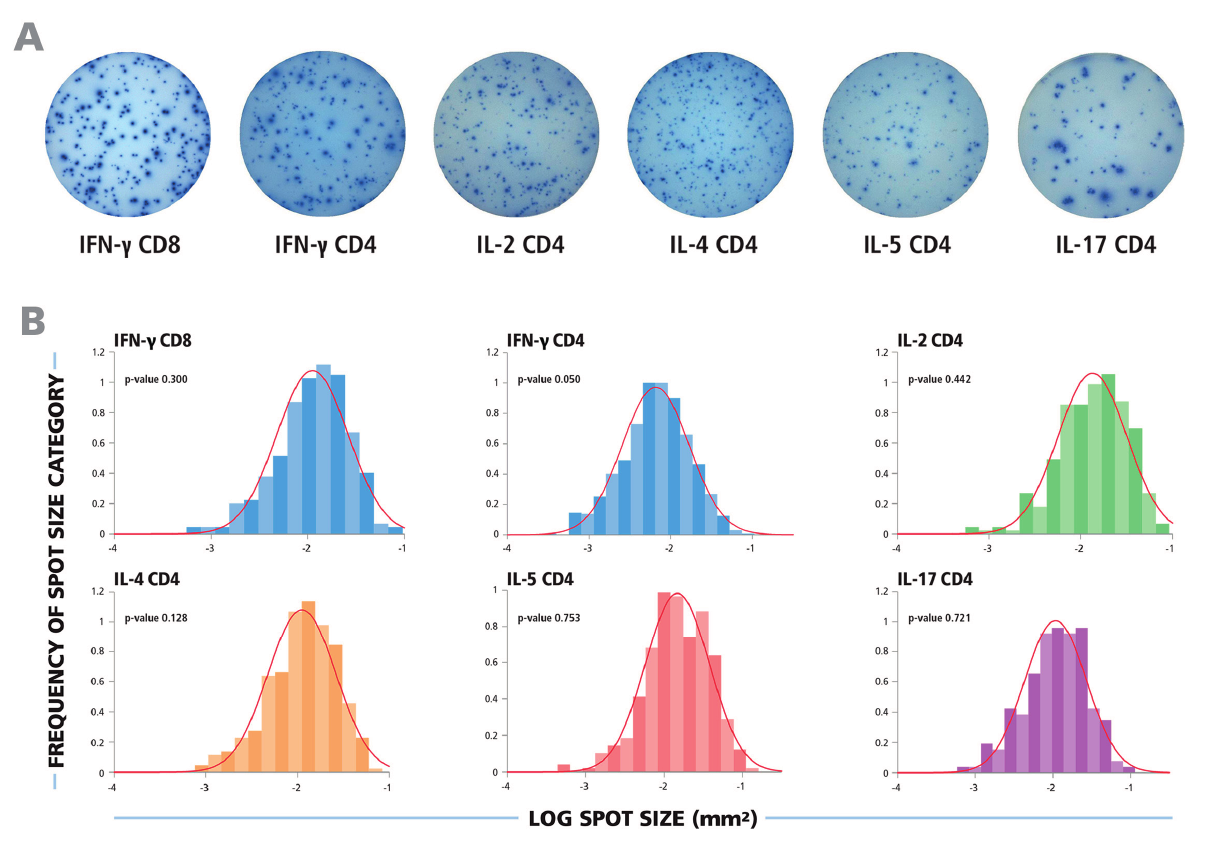
Figure 1. The spot size distributions for different cytokines follow Log Normal function. ( A ) Representative images of ELISPOT wells are shown for cytokines produced by CD8 or CD4 cells, as specified. ( B ) The experimental size distributions of typical recall responses are shown as histograms for the specified cytokines with the theoretical Normal functions overlaid as red lines. To test for the normality of the spot size distributions, the Kolmogorov– Smirnov goodness of fit test was